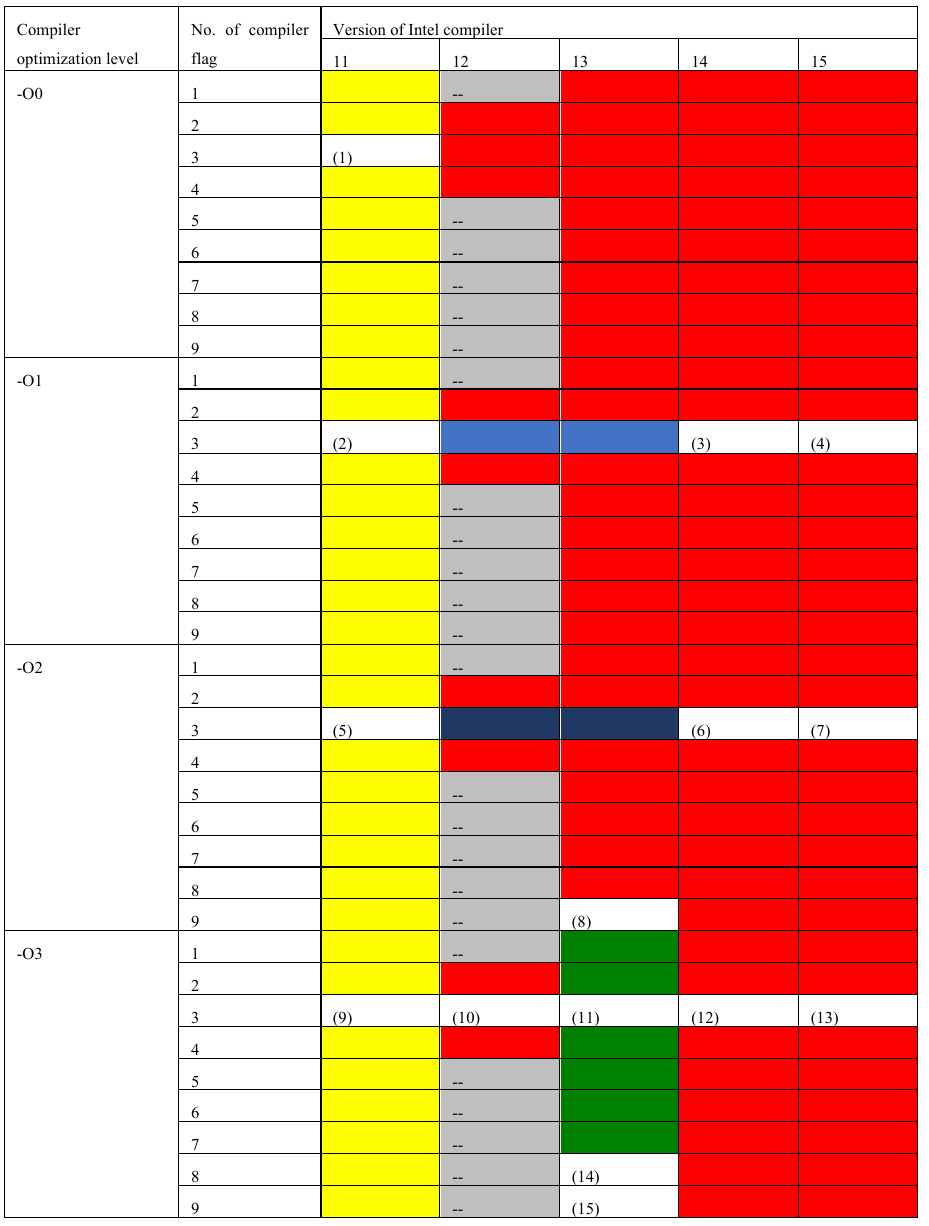
Table 9: Similar to Table 8 except for the simulation results of POP2. Each table cell with “--1 “ means that the compilation of POP2 fails under the corresponding compiling setup, due to